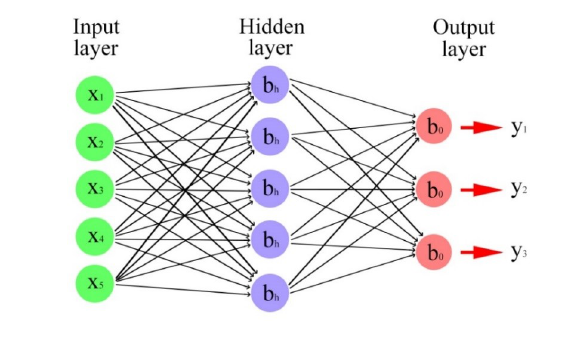
Fig. 2. Schematic diagram of the three-layer